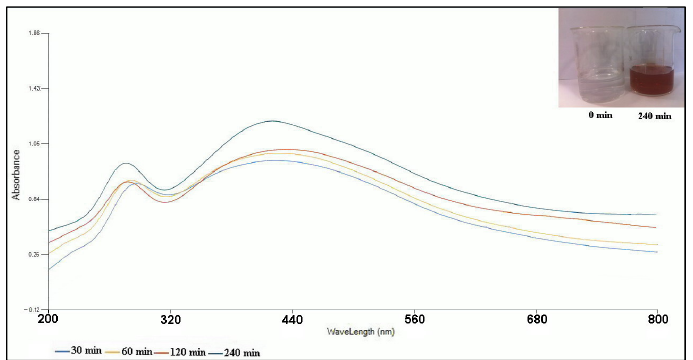
Figure 1. UV–Vis spectra of the greenly synthesized AgNPs by the A. tribuloides root extract at various time intervals. The color change of the reaction mixture is also shown.